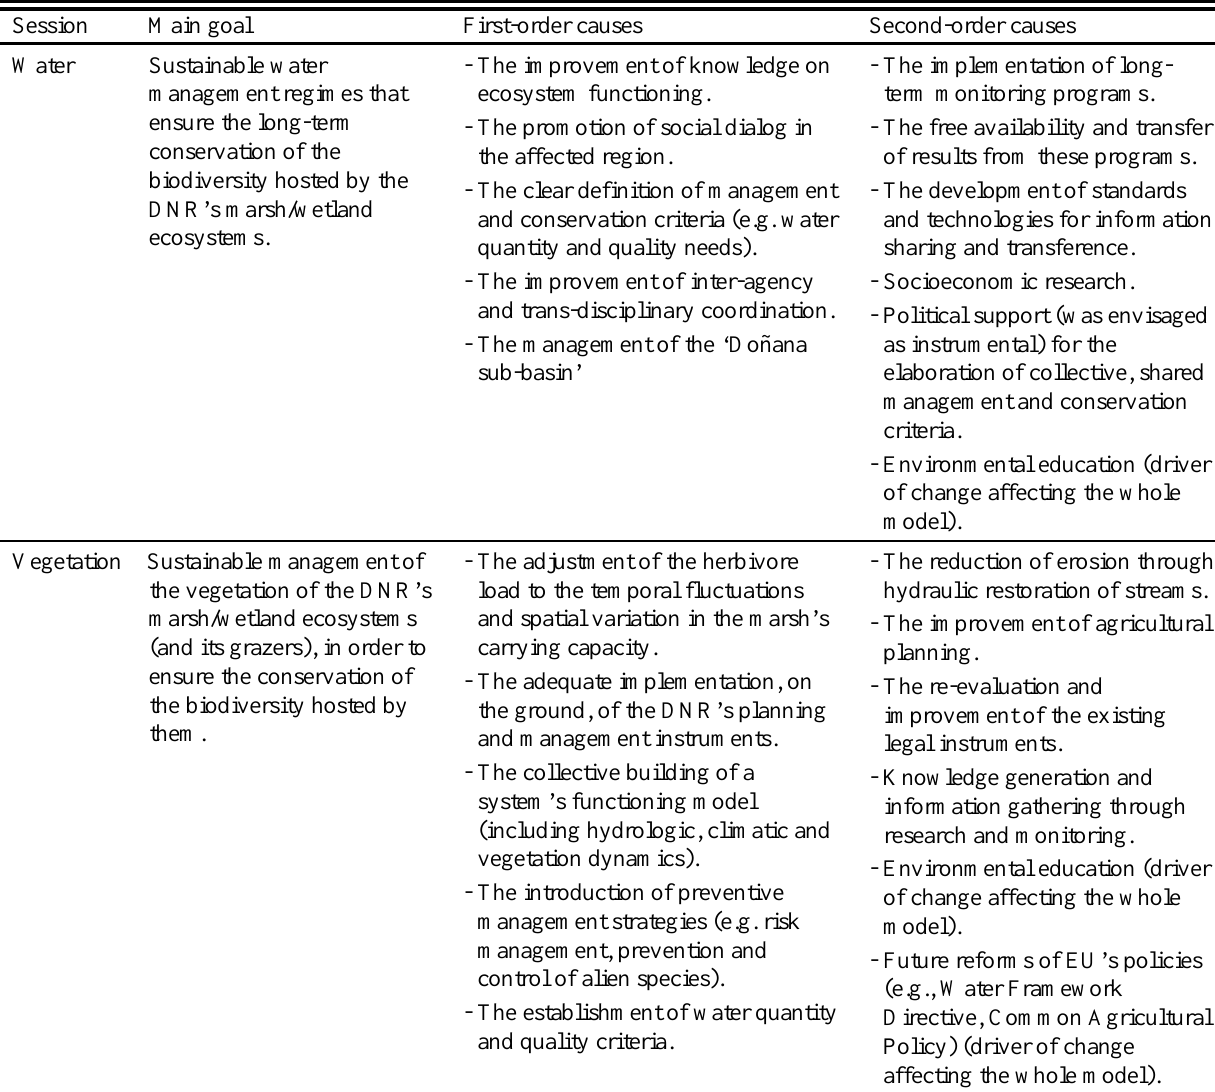
Table A2.4. Synthesis of first-order and second-order causes recognized as drivers of change towards the accomplishment of the main goal, by the participants in the research-management workshop’s Group Model Building